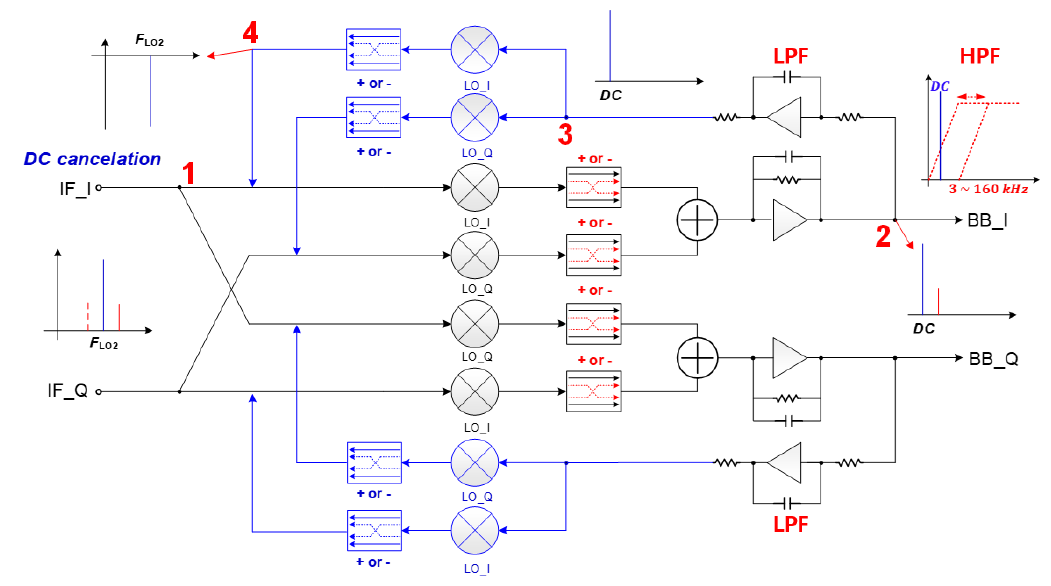
Figure 13. DC offset cancellation technique in the